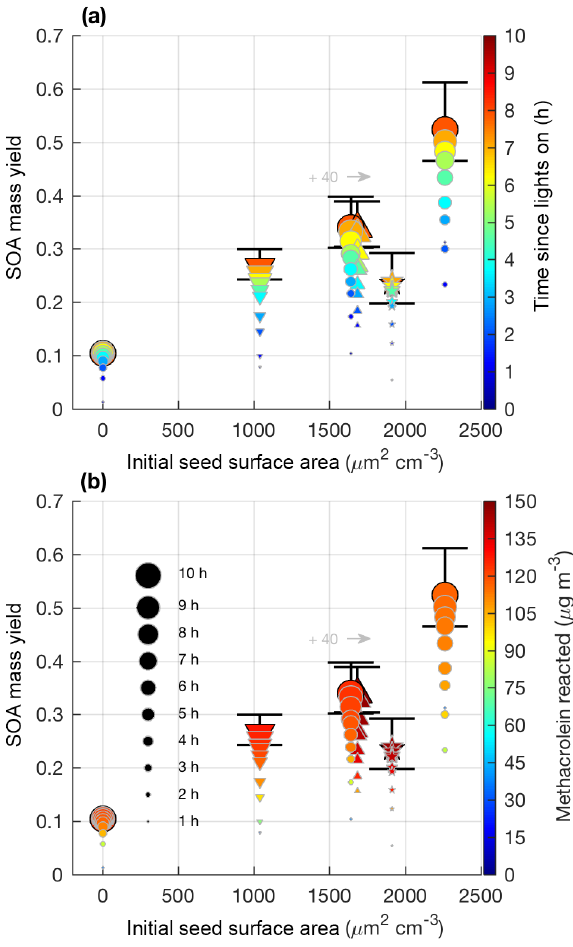
Figure 7. SOA mass yield (60min averages) versus initial seed sur- face area for all 2MGA pathway experiments. Colors represent time since lights on (a) and extent of methacrolein reacted (b) . Marker size represents time since lights on. Uncertainty is shown in black lines and described in Sect. 4.1. Markers represent 25–26 ◦ C (dot), 13 ◦ C (inverted triangle), 32 ◦ C (triangle), and new chamber with less wall charging (star). Two experiments were performed at nearly the same seed surface area. To enhance viewing, experiment M6 (32 ◦ C; triangle) is shifted to the right by 40µm 2 cm − 3